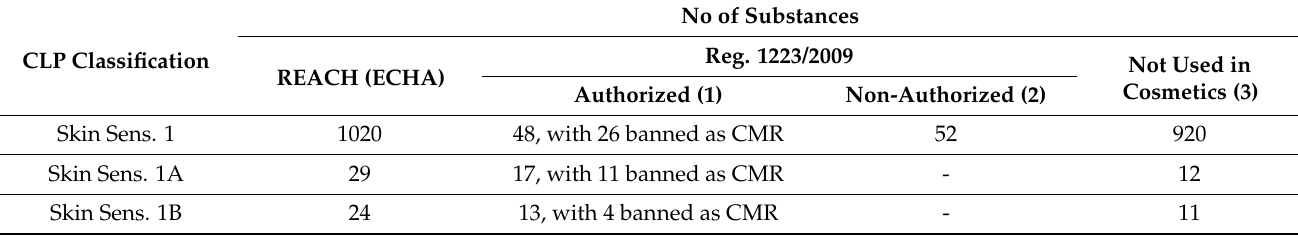
Table 5. Skin sensitizers regulatory status from chemical and cosmetics legislation perspective. Details on the Skin Sens. CLP sub-categorization and cosmetics